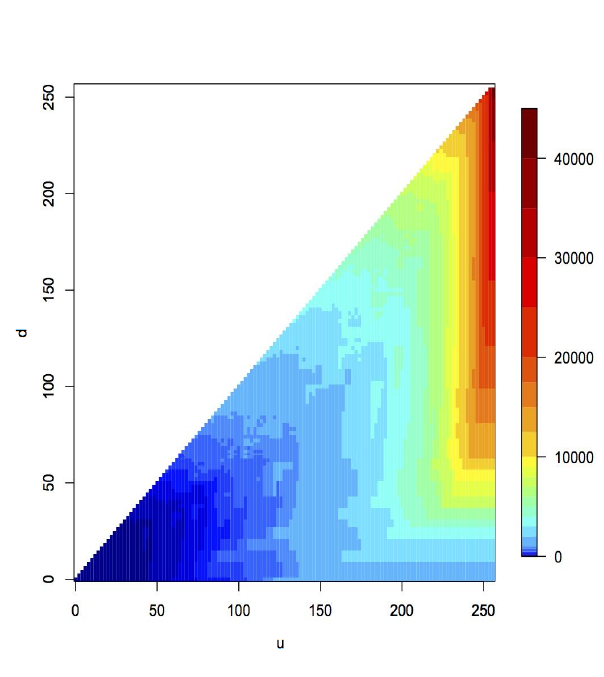
Figure 4: Loss for different values of u and d .